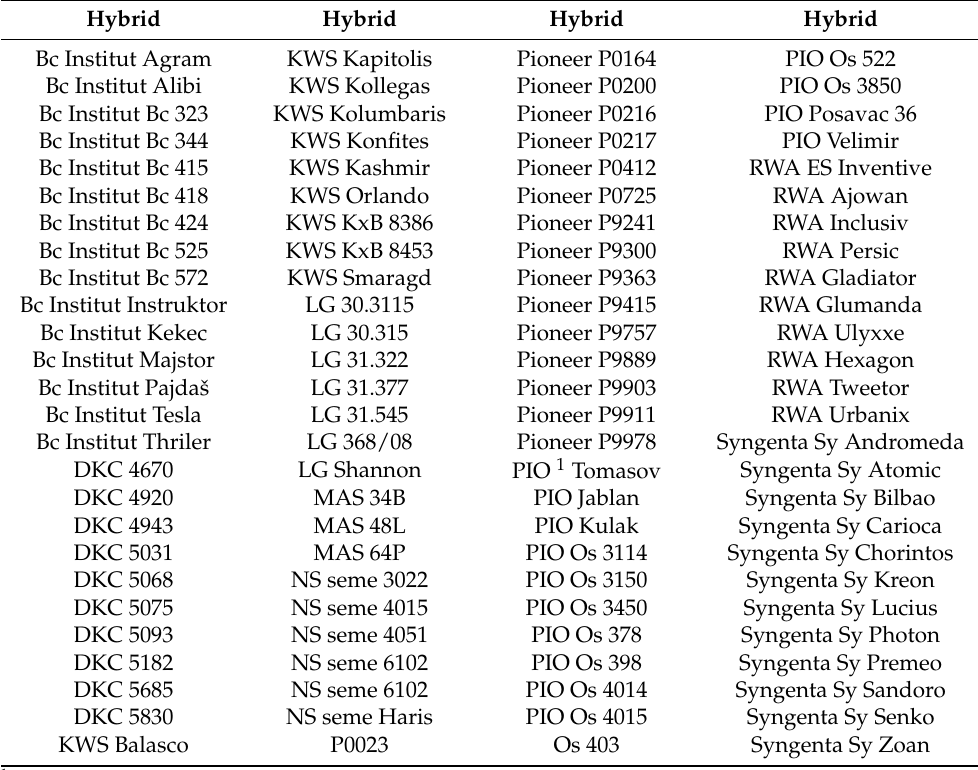
Table 1. List of tested commercial maize